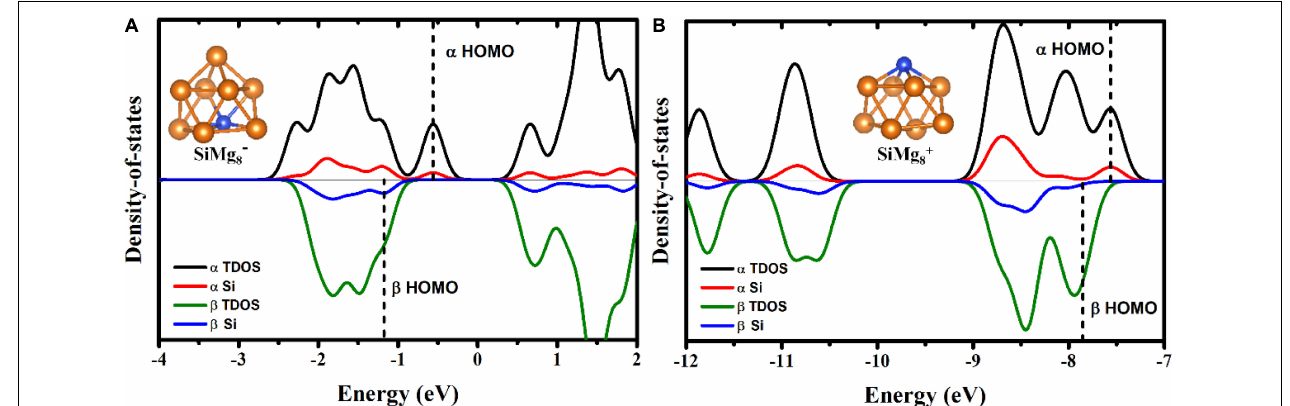
FIGURE 7 | α - and β - elections TDOS and PDOS of the most stable clusters of panels (A) SiMg − 8 and (B) SiMg + 8 .